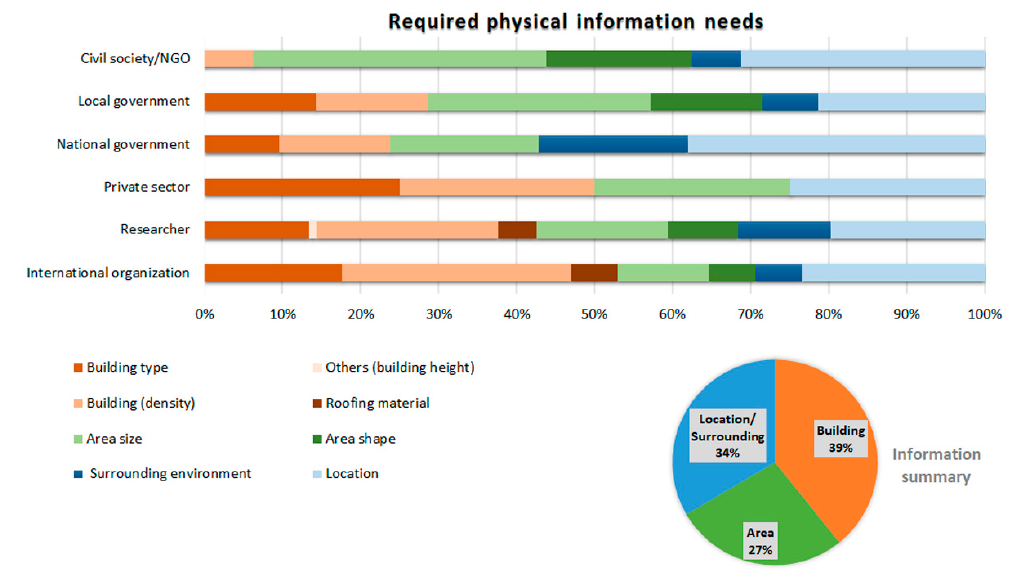
Figure 12. Results of the online expert survey on the required physical deprived areas characteristics (multiple answers).